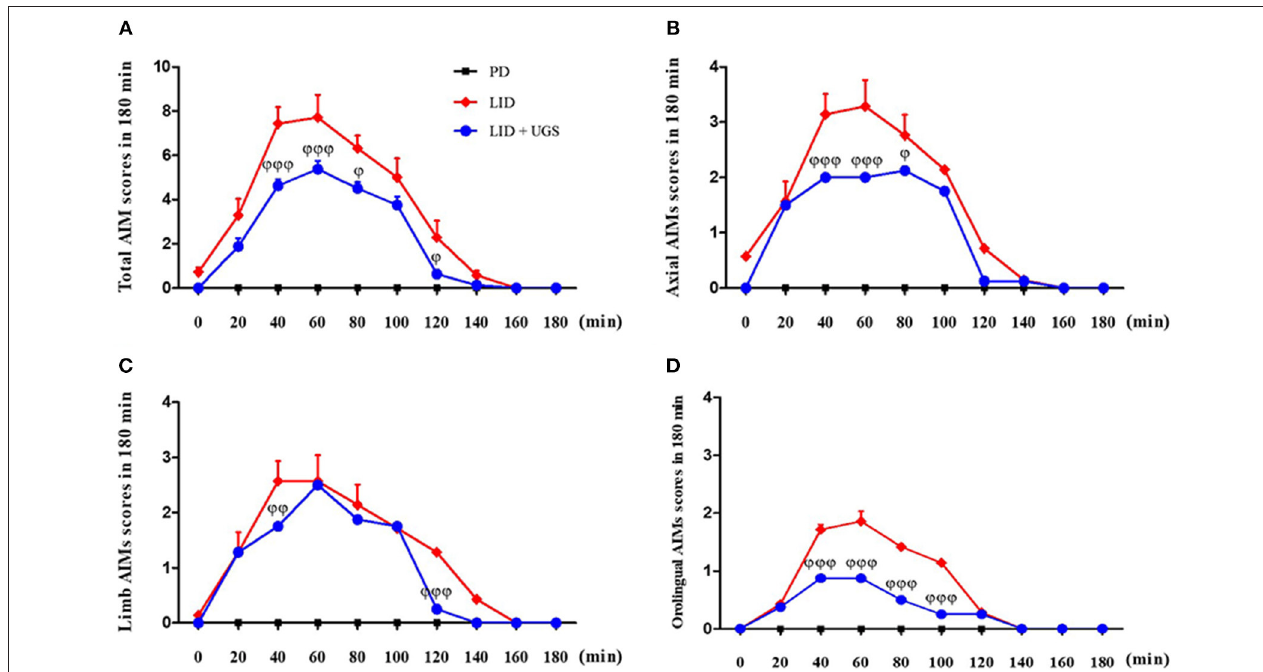
FIGURE 6 | UGS decreased the peak score of LID during 180min after L-dopa injection. All testing sessions were performed at the 10th day of L-dopa treatment. The sum of axial, limb, and oroligual (A) , axial (B) , forelimb (C) , and oroligual (D) AIMs on each testing session were rated every 20min. There is no significant difference of interaction time as treating UGS in LID mouse. Values are given as the mean ± S.E.M. ( N = 6). The significance of differences was analyzed by repeated measures of ANOVA with Bonferroni’s post hoc tests: φ p < 0.05, φφ p < 0.01, and φφφ p < 0.001; mean values were significantly different from the LID group.